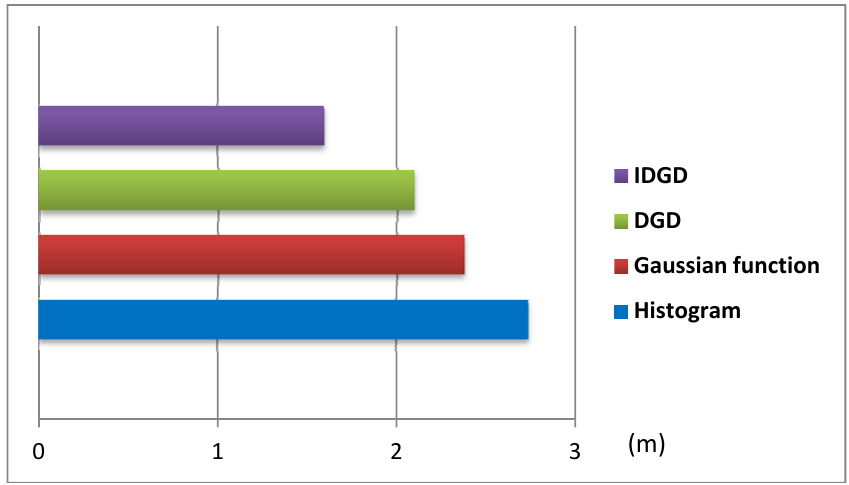
Figure 7. The average error using different models in test